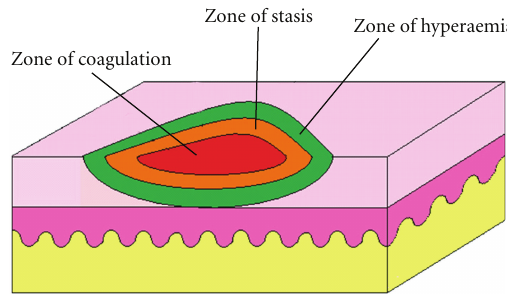
Figure 2: Illustration of zones of burn injury. The centre part (zone of stasis) is the worst a ff ected and the one surrounding it (zone of stasis) is characterised by decreased tissue perfusion. The burn depth in this zone can be prevented from worsening by appropriate first aid and adequate initial fluid